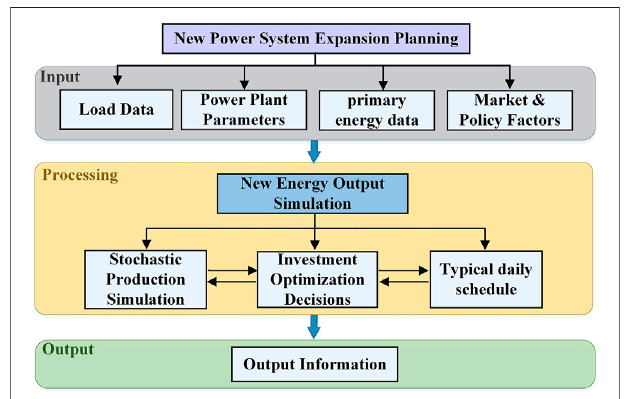
FIGURE 1 | Structure of the new power system